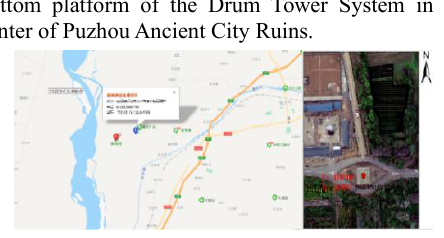
Figure 1. Map of Drum Tower, Puzhou ancient city The platform at the bottom of the Drum Tower is square in plane, as shown in Figure 2. The platform is 9.4 meters high and there are doorways on all sides that connect with each other in the cross. The original four doorways all have inscribed boards and couplets. bottom of 1 meters high ghee; Only about 1 meter high is left at the bottom of the four-faced brick masonry, while the rest have been dismantled and lined with exposed small brick masonry. The existing bottom platform of the Drum Tower is mainly missing most of the outer clad city bricks. The purpose of this study is to digitize the existing wall of the bottom platform of the Drum Tower and estimate the amount of bricks used for the detached part of the outer cladding brick.